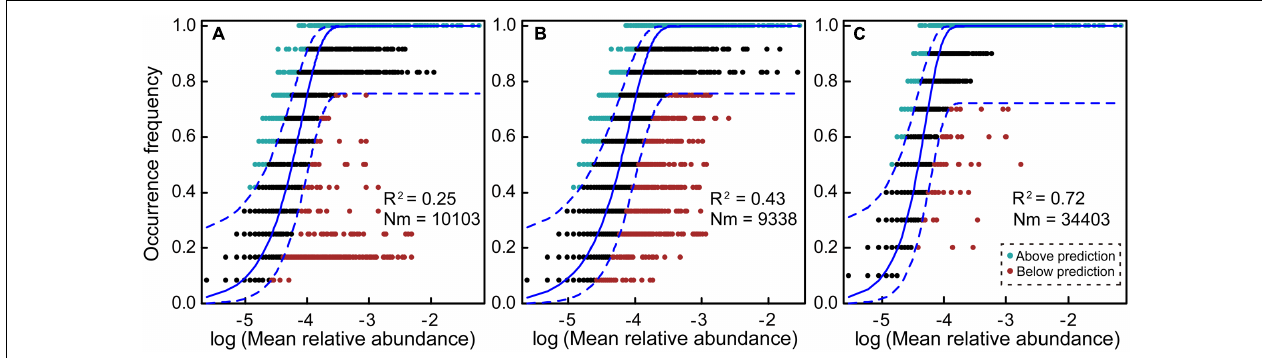
Environment, community variation explained by pure environmental factors; Spatial, community variation explained by pure spatial factors; Shared, community variation explained by joint effect of environmental and spatial factors. Bold values indicate statistical significance (P < 0.05). Negative value of adjusted coefficients of determination (Adjusted R 2 ) was converted to zero. Water (10 sites) indicated removing sites N2 and N3.